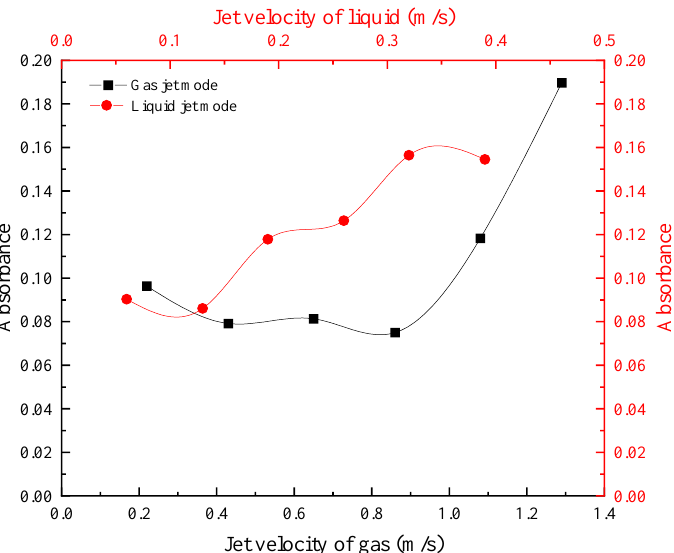
Figure 10. Influence of jet velocity on reagent adsorption.